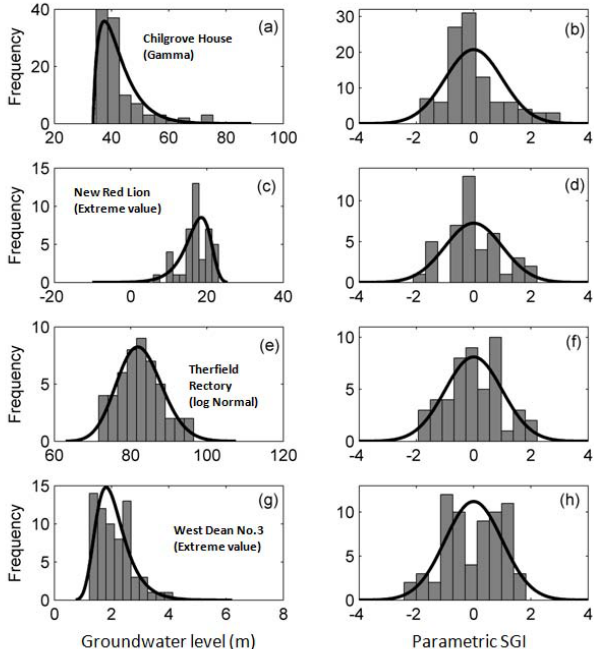
Fig. 4. Examples of histograms of groundwater levels and best fit- ting parametric distributions (a, c, e, g) , and corresponding his- tograms of normalised values and standardised normal distribu- tion for groundwater level data (b, d, f, h) for Chilgrove House in November, New Red Lion in April, Therfield Rectory in May, and West Dean No. 3 in